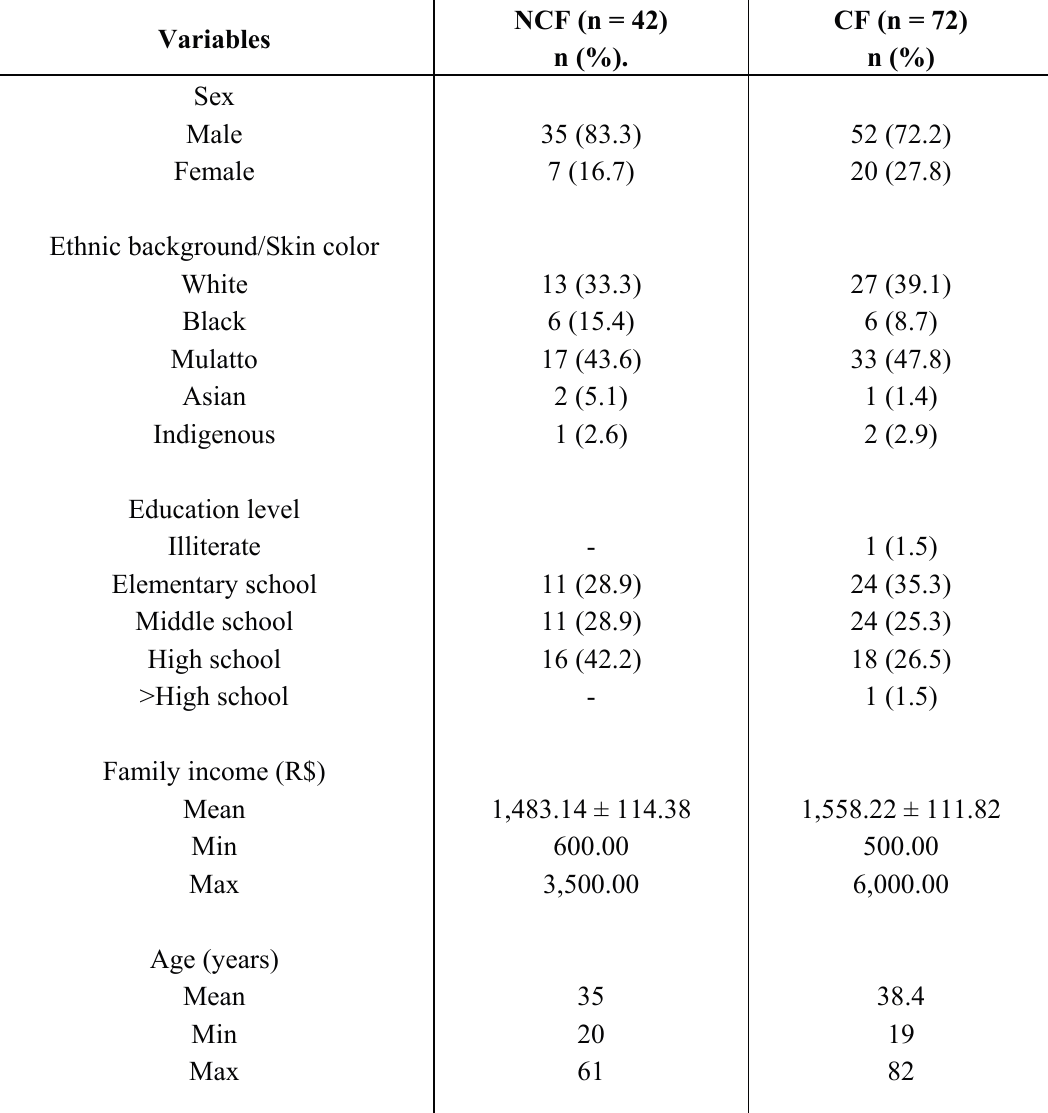
Table 2. Demographic and occupational characteristics of the study population (114